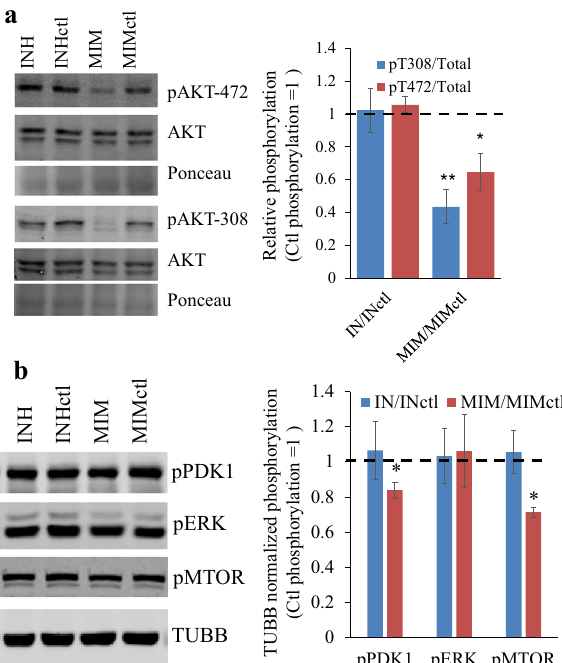
Figure 8. Suppression of the PI3K/AKT/mTOR axis by miR1908-5p. Western blot analyses of HuH-7 cells treated for 72 h with either Mimic inhibitor or miR1908-5p mimic, or their matching controls. ( a ) AKT phosphorylation. Ponceau of the 50 kDa region as loading control is shown. Representative Western blots (2 distinct blots) on the left. Right, the ratio of phospho to non-phospho signal normalized to the matching miRNA (mimic or inhibitor control) value, from 3 biological replicates (average ± S.D). ( b ) PDK1, ERK and MTOR phosphorylation. Representative Western blot on the left (single reprobed blot). Right, quantification of 3 biological replicates (average ± S.D), relative to the TUBB signal and normalized to the matching control oligo value. MIM or INH vs matching ctl: * p < 0.05; ** p <